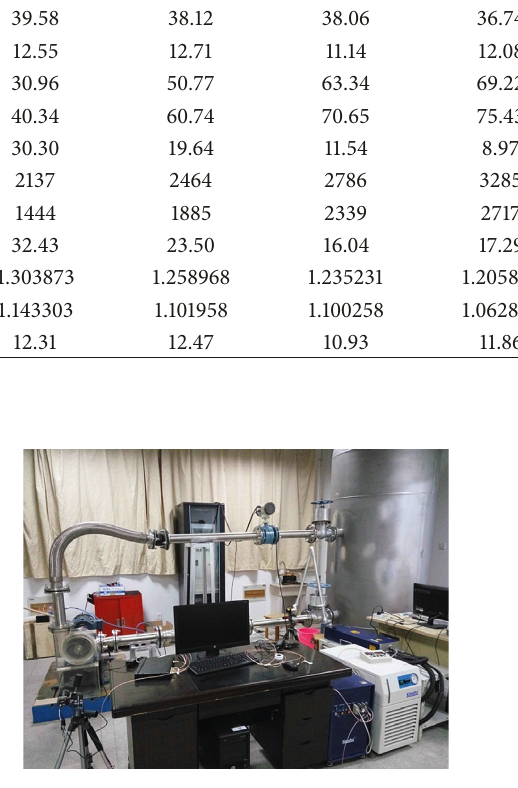
Figure 8: PIV system test platform.